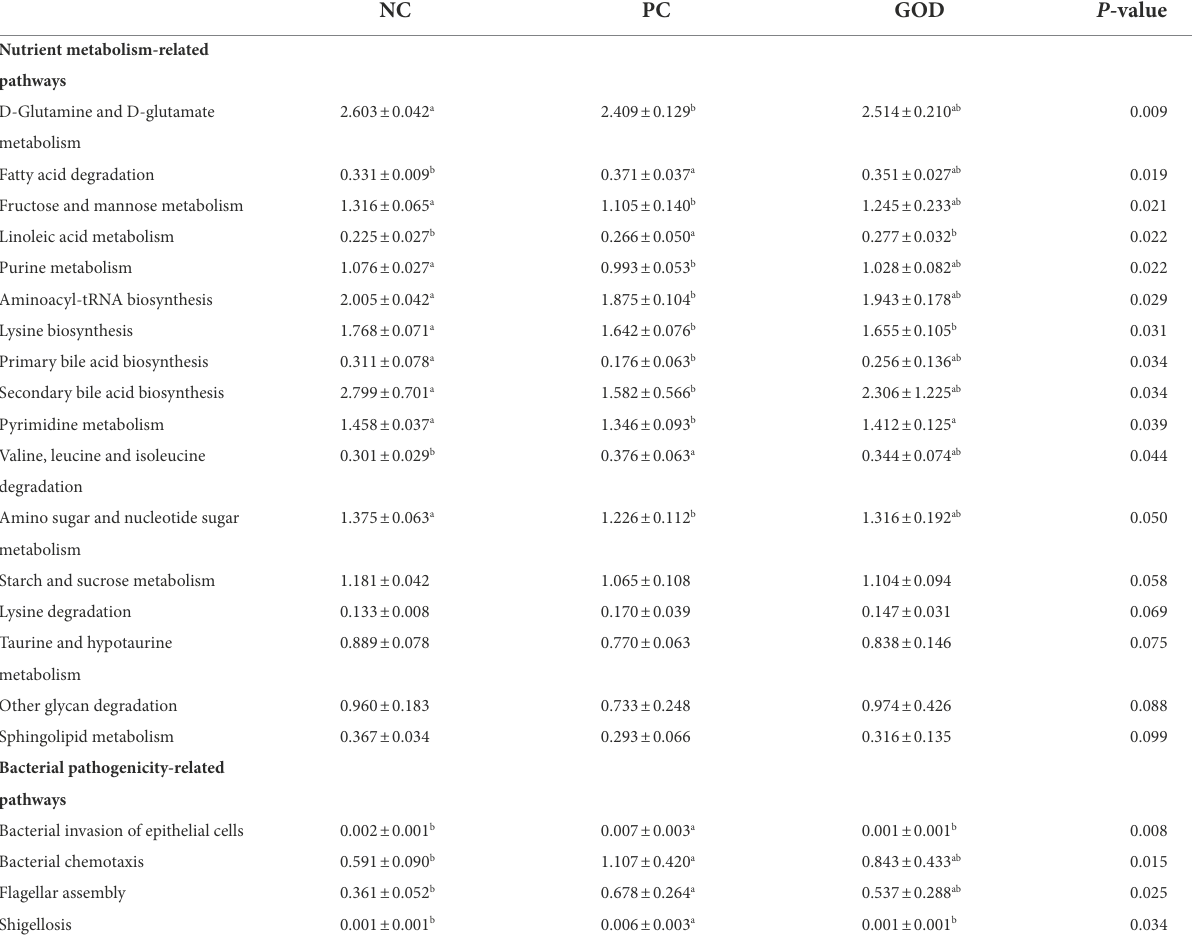
TABLE 9 Comparison of the predicted pathways of piglet gut microbiota among groups 1 .